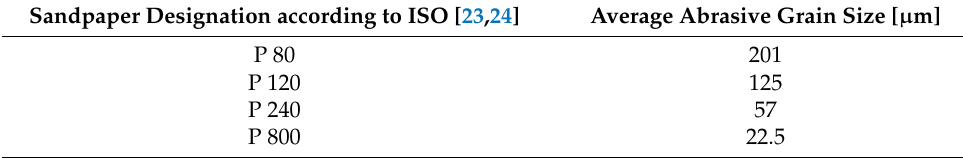
Table 2. Sandpapers used in testing.